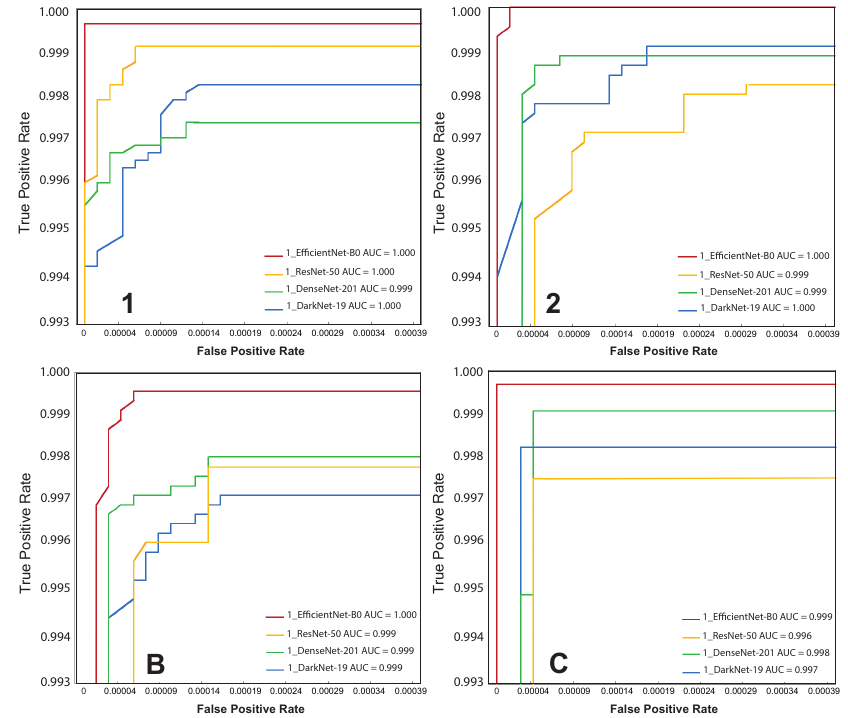
Figure 8. Magnified ROC curves of the top 4 classes from the 4 CNN networks.